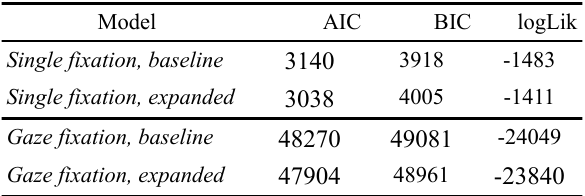
Table 3 Goodness of Fit Statistics for the Baseline and Expanded